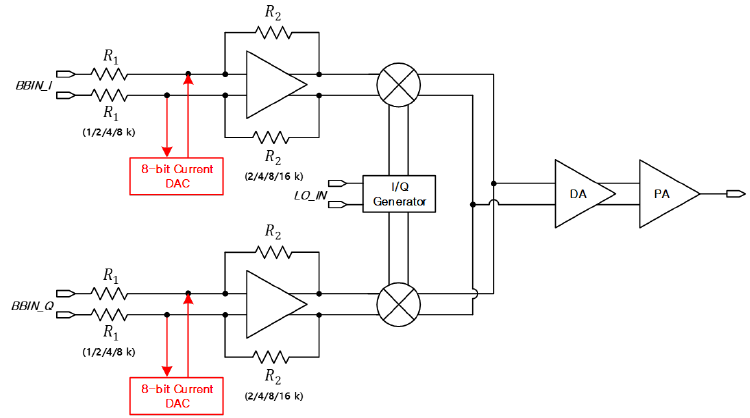
Figure 5. Block diagram of direct conversion structure